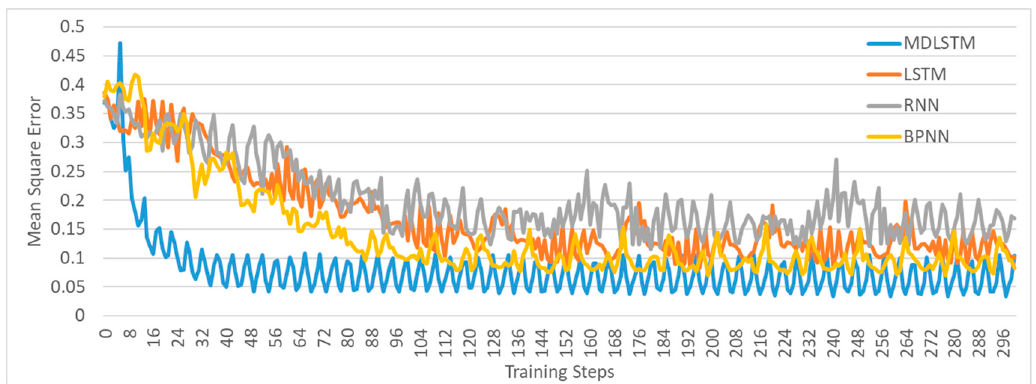
Figure 9. Performance of MDLSTM, LSTM, RNN and BPNN on the training dataset. MDLSTM means the “multi-dimensional long-short term memory neural network”. LSTM means the “long-short term memory neural network”. RNN means the “recurrent neural network”. BPNN means the “back-propagate neural network”. Table 4. Performance of MDLSTM, LSTM, RNN and BPNN on the testing dataset. Testing Indicator